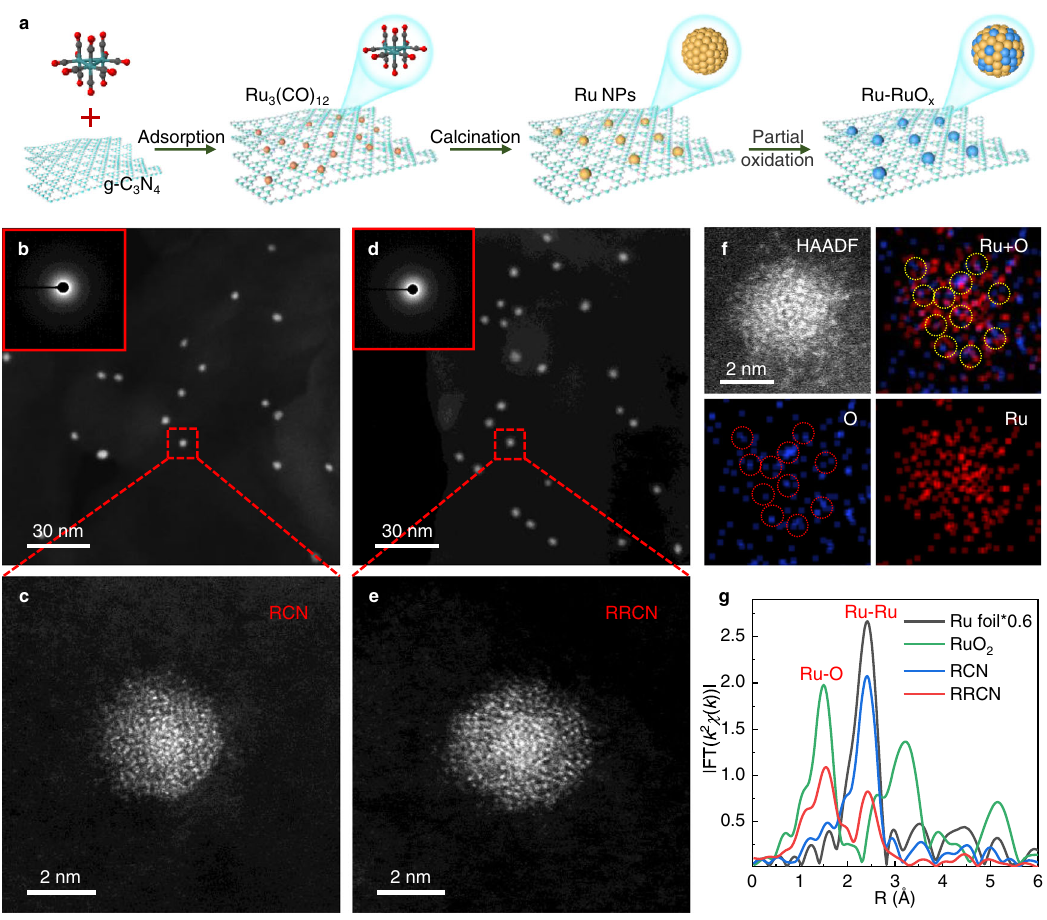
Fig. 2 | Preparation and characterization of the photocatalyst. a Schematic illustrationofthepreparationstrategyforRCNandRRCN. b – e HAADF-STEM,SEAD (inset),andhigh-resolutionAC-HAADF-STEMimagesofRCN( b , c )andRRCN( d , e ),